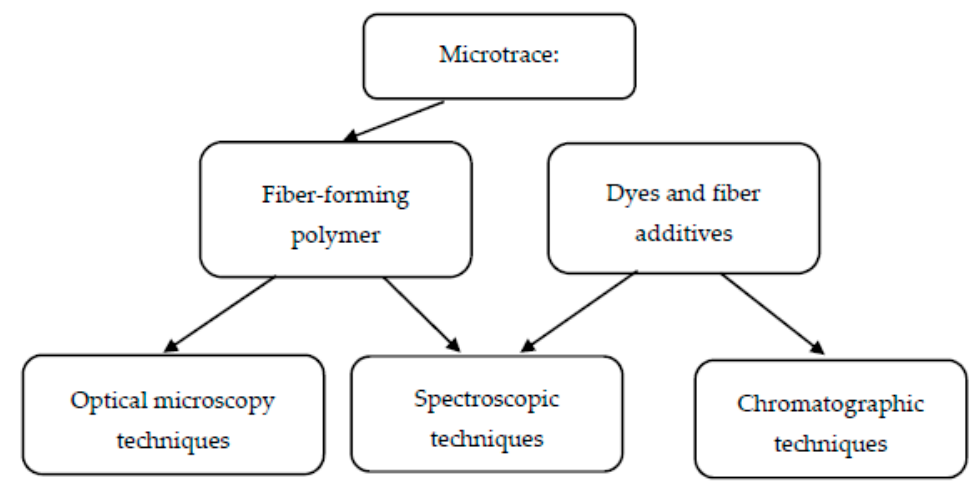
Figure 10. Scheme of forensic examination of textile fibers.